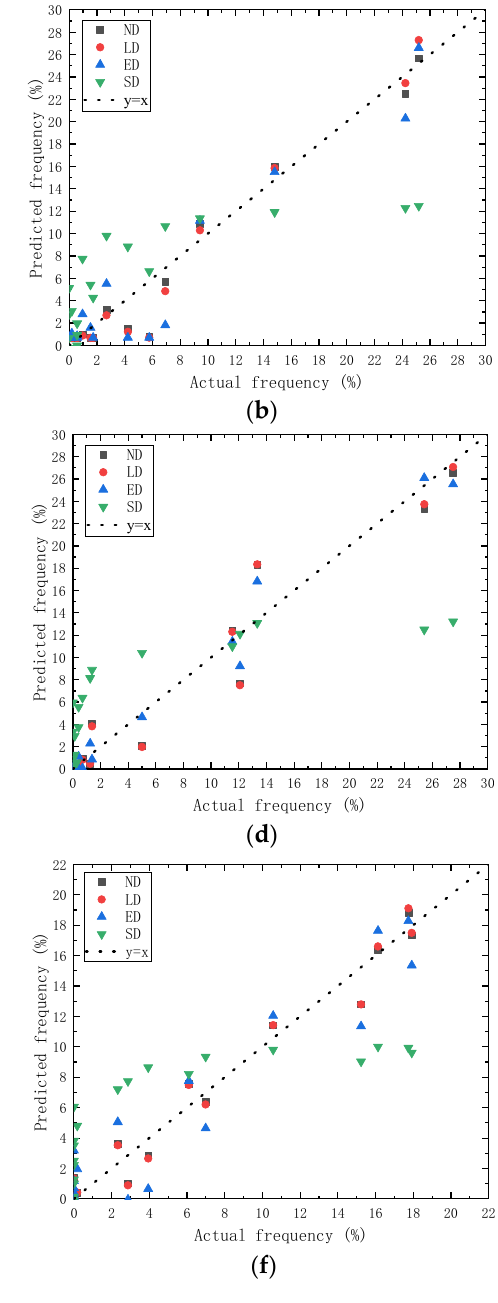
Figure 9. Relationship between actual frequency and predicted frequency: ( a ) Test section A; ( b ) Test section B; ( c ) Test section C; ( d ) Test section D; ( e ) Test section E; ( f ) Test section F.